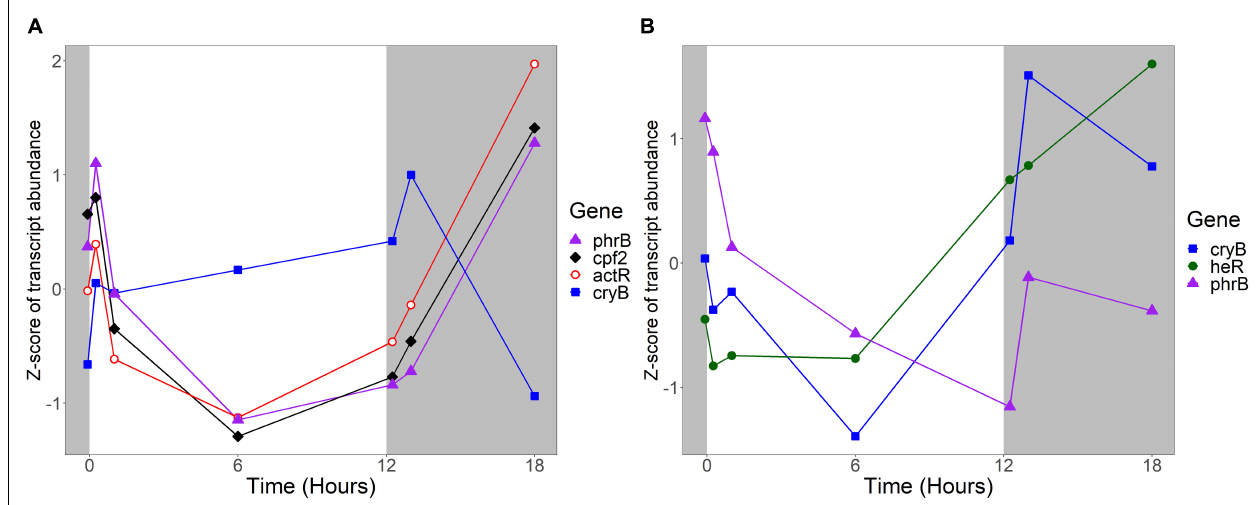
FIGURE 9 | Expression of putative light sensors. Expression is plotted as z-score of each transcript. (A) Expression of potential light sensors in R. lacicola , which include an actinorhodopsin ( actR ), a DNA photolyase ( phrB ), a CryB-type cryptochrome ( cryB ), and another member of the cryptochrome-photolyase superfamily of proteins ( cpf2 ). (B) Expression of potential light sensors in A. photophilum strain MWH-Mo1, which has a heliorhodopsin ( heR ), a DNA photolyase ( phrB ), and a CryB-type cryptochrome ( cryB